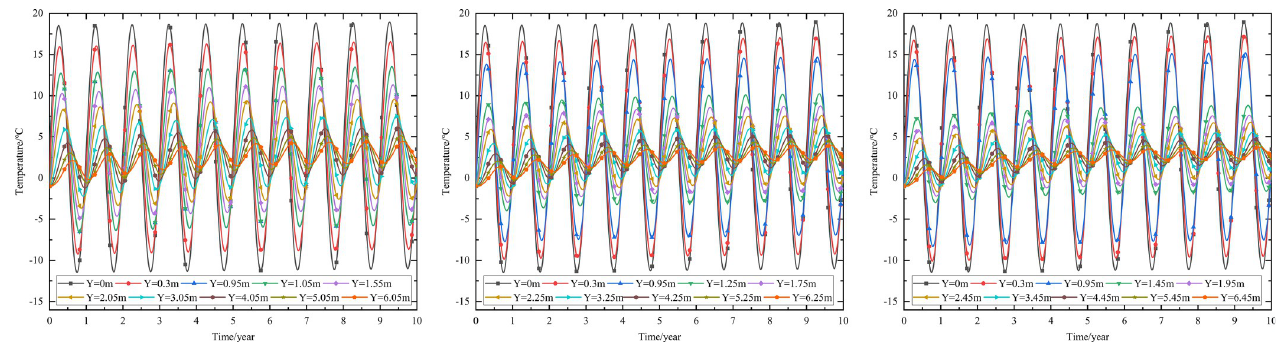
Fig 8. Temperature-time curves of pavement center at the subbase layer thickness of (a) 0.10 m, (b) 0.30 m, and (c) 0.50 m.